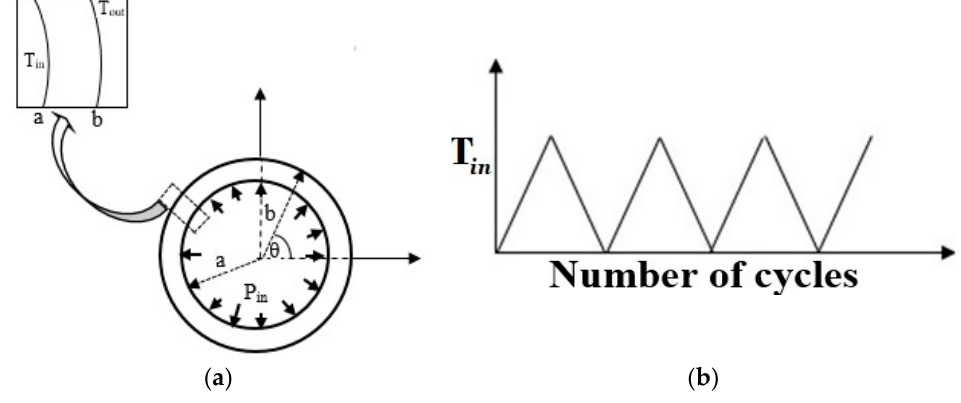
Figure 2. ( a ) Physical model of internally pressurized an FGM cylindrical shell subjected to a cyclic temperature gradient through-thickness. ( b ) Cyclic thermal load history pattern applied to the thick-walled FGM cylindrical shell.